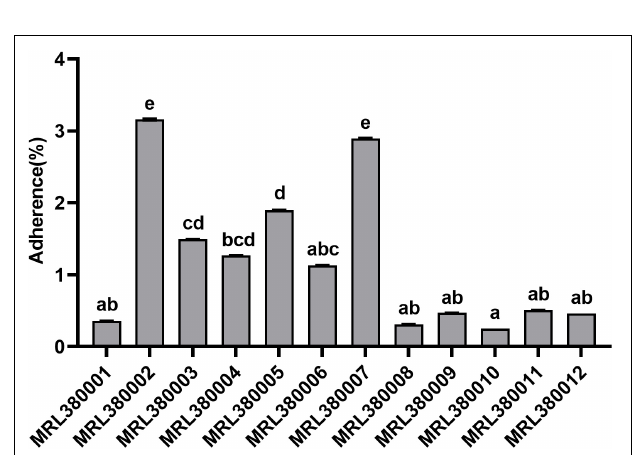
FIGURE 6 | Adherence to of Caco-2 cells by different strains of STEC. The same letter indicates that there was no significant difference between each other, and the absence of the same letter indicates that there was a significant difference between each other ( p < 0.05). Results were expressed as percent of adherent bacteria with respect to inoculum.